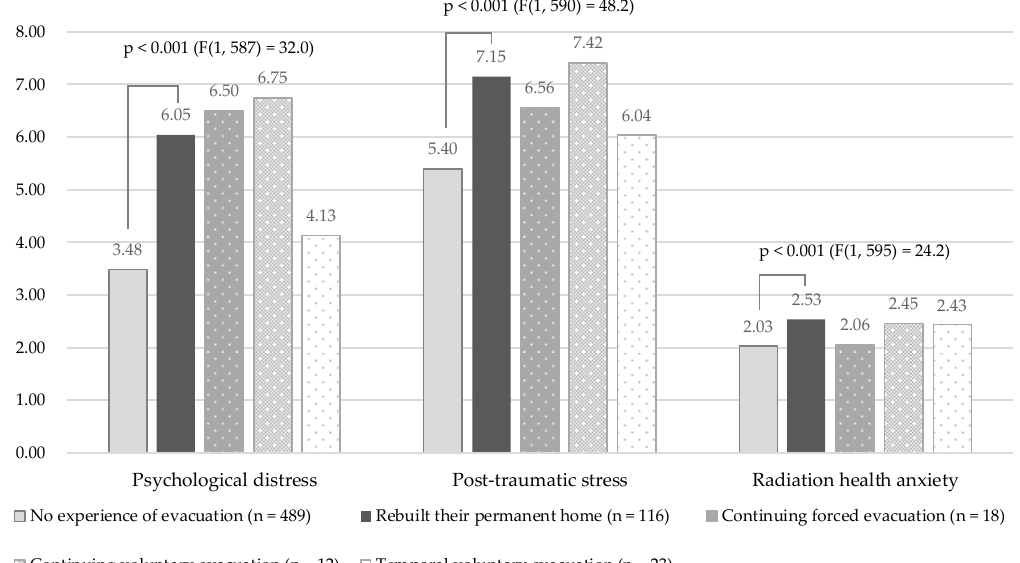
Figure 4. Comparison between those who rebuilt their permanent home and those with no evacuation experience in terms of psychological distress, post-traumatic stress, and radiation health anxiety.